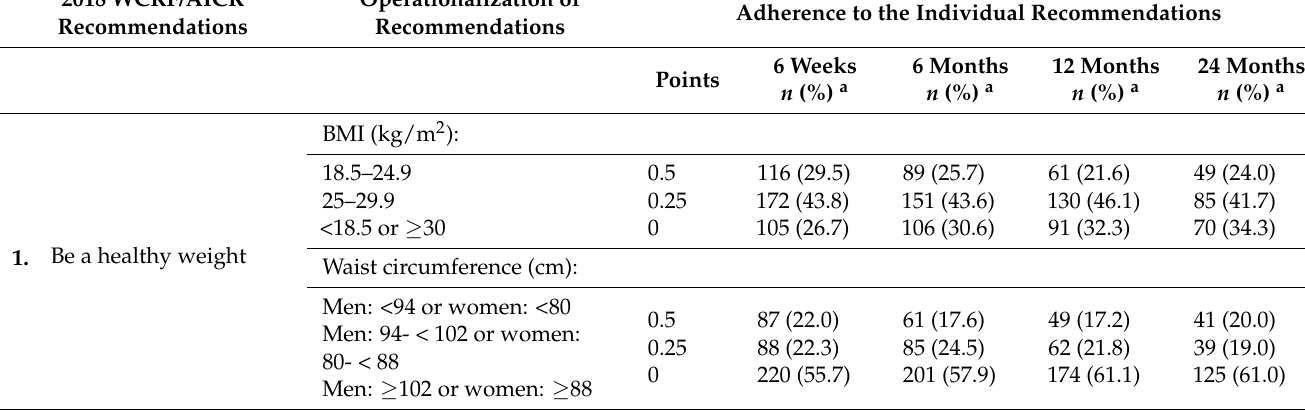
Table 1. Adherence to the 2018 WCRF/AICR recommendations [12] by colorectal cancer survivors from 6 weeks to 24 months